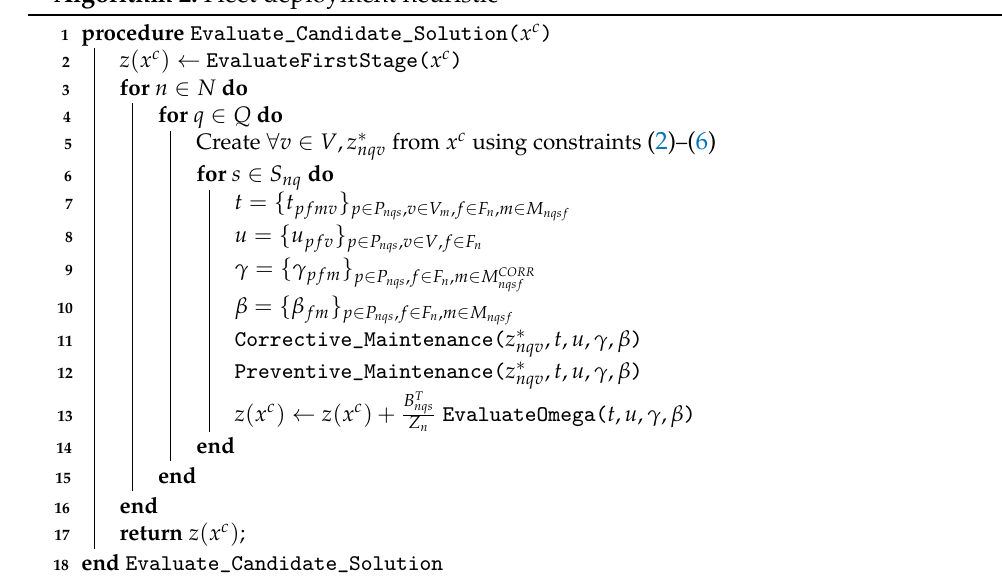
Algorithm 2: Fleet deployment